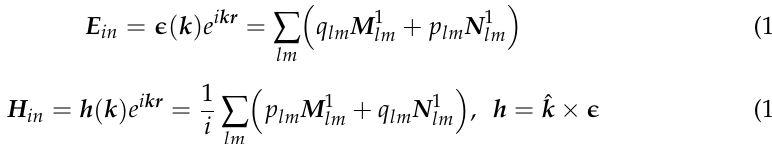
(cid:12) (cid:12) 2 (cid:2870) (cid:12) (cid:12) of the of the eigenproblem (cid:12) f qlm (cid:12)